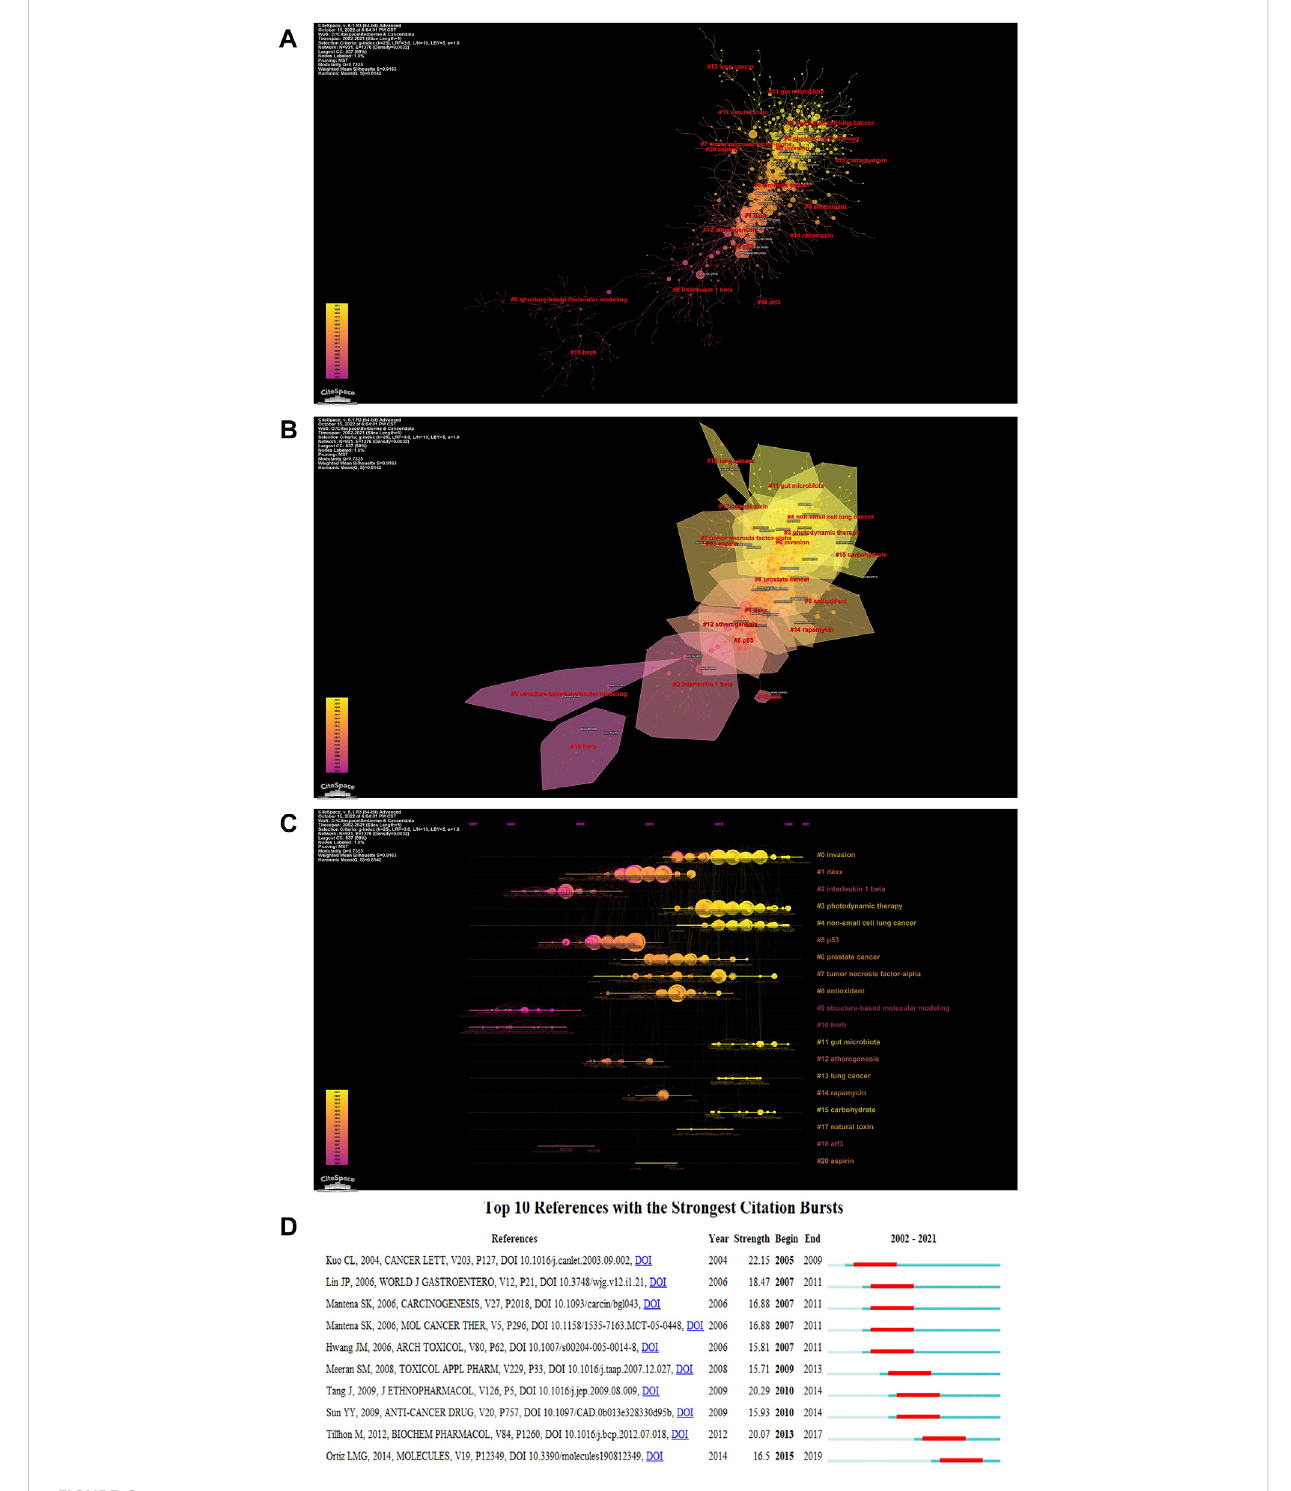
FIGURE 6 Analysisofco-citedreferences. (A) Visualizednetworkdiagramofco-citeddocuments. (B) ClusterAnalysisoftheco-citedarticles. (C) Timelineview of the co-cited articles. (D) The top 10 references with the strongest citation